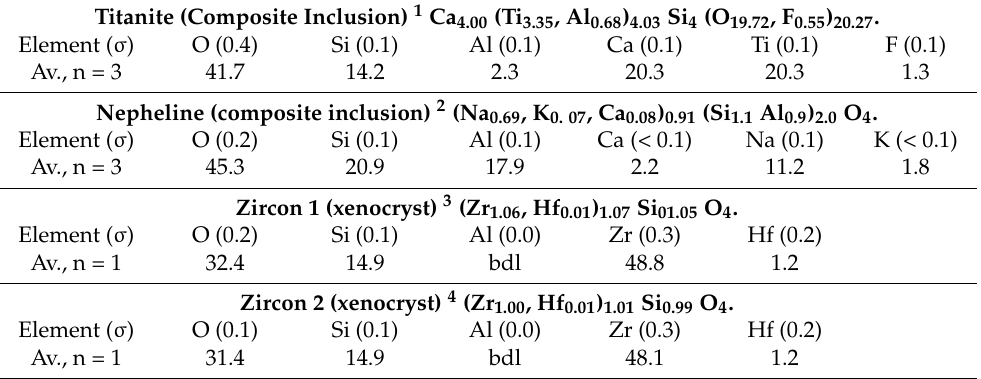
Table 2. EDS element analyses (wt %), inclusion mineral phases, Thurein Taung